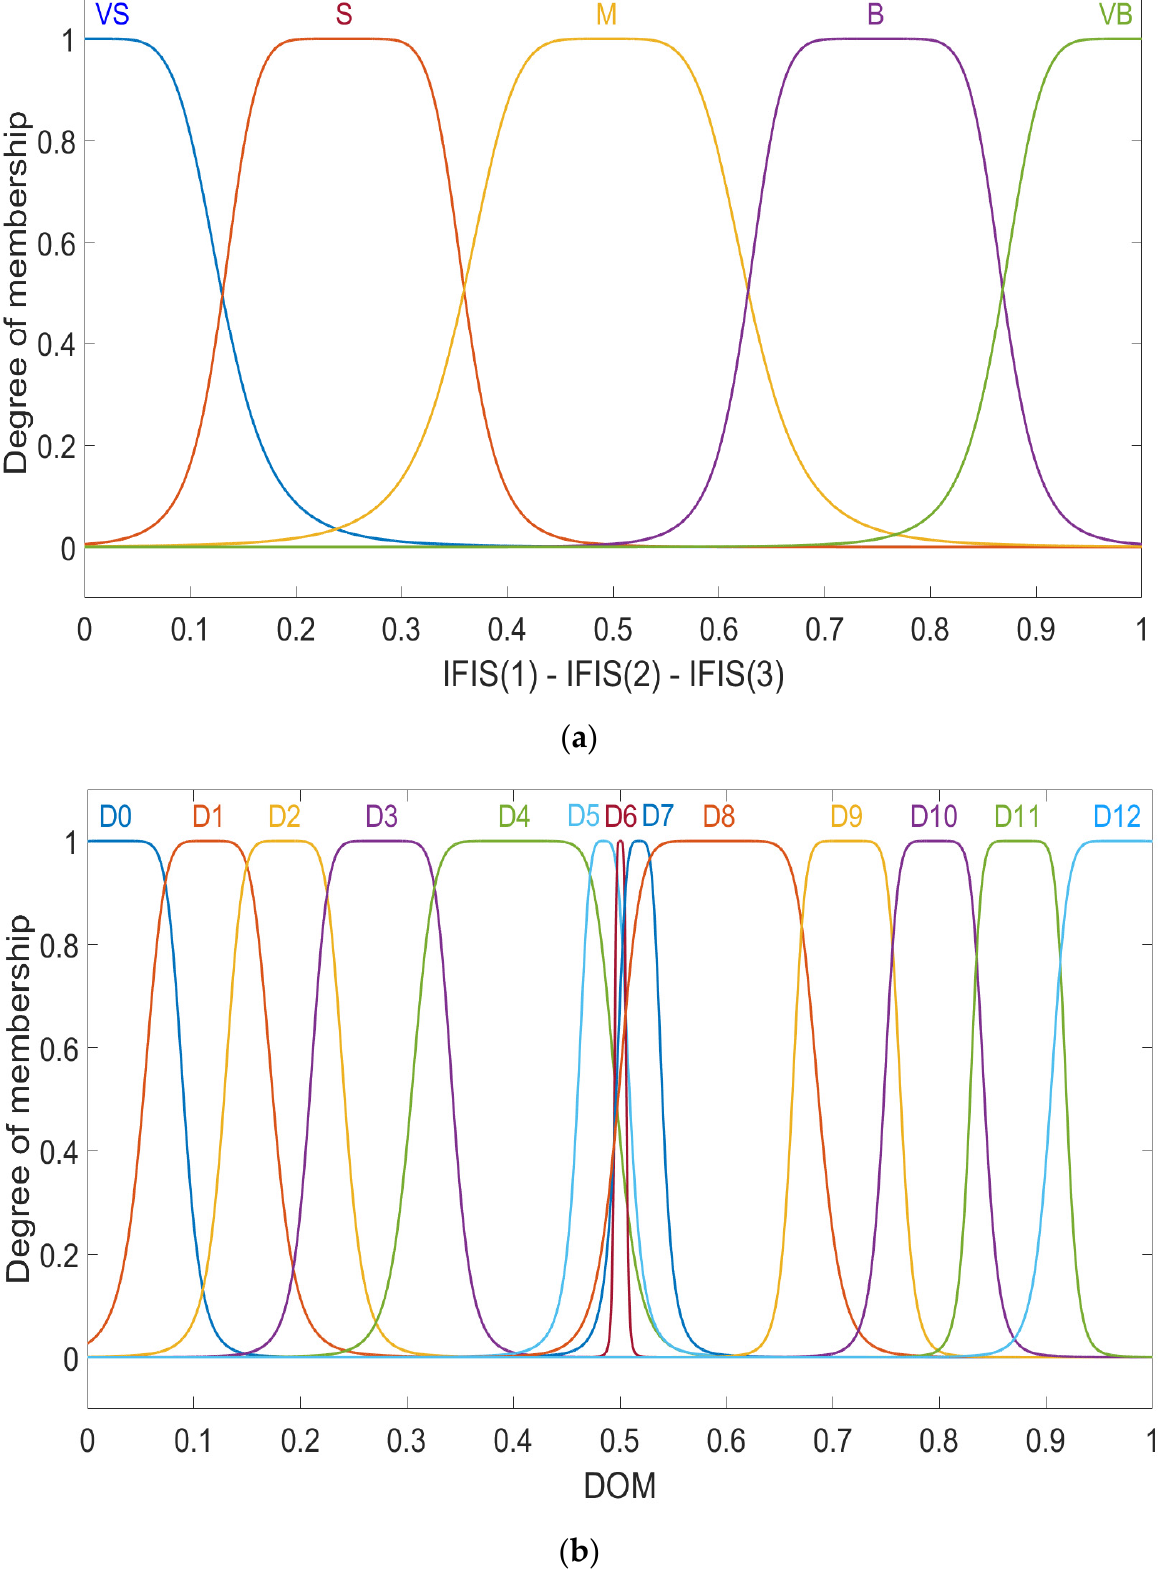
Figure 3. The membership functions defined for the inputs and outputs of the FIS: ( a ) IFIS(1), IFIS(2) and IFIS(3) inputs; ( b ) DOM output.